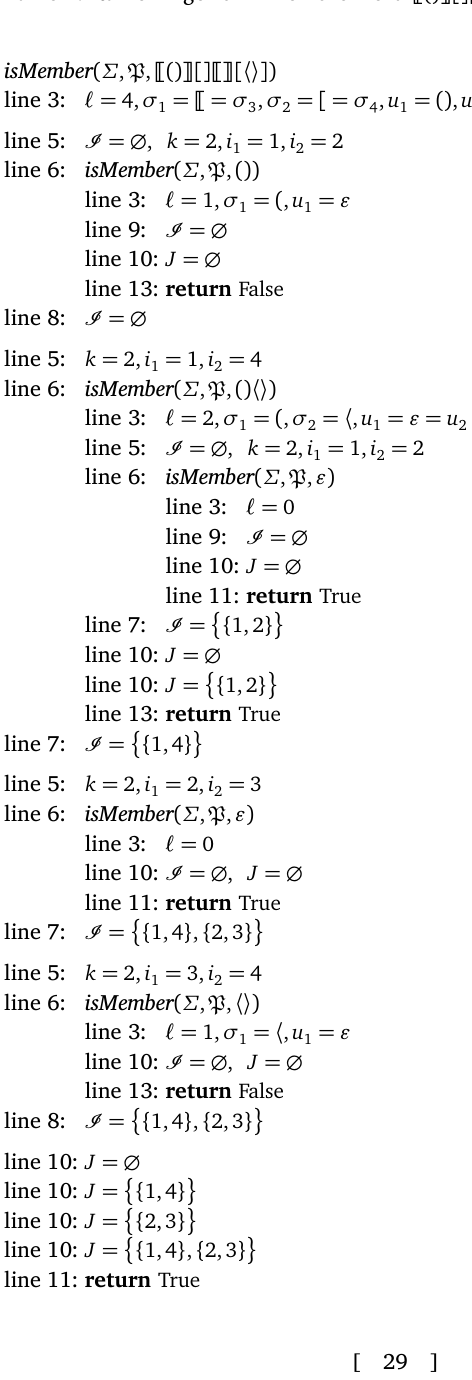
Table 2: Run of Algorithm 2 on the word ⟦ () ⟧ [] ⟦⟧ [ hi ] .